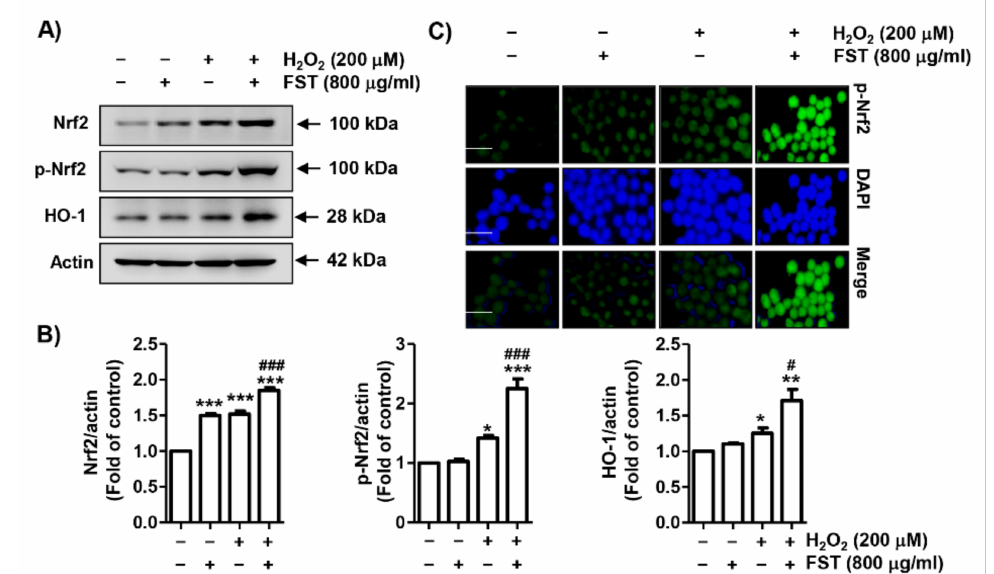
Figure 5. Activation of nuclear factor erythroid 2-related factor 2/ heme oxygenase-1 (Nrf2/HO-1) signaling pathway by FST in H 2 O 2 -treated MC3T3-E1 cells. Cells were pre-treated with or without FST (800 µ g/mL) and exposed to H 2 O 2 (200 µ M) for 24 h. ( A ) The expression of Nrf2, phos- phorylated (p)-Nrf2, and HO-1. Actin was used to loading control. ( B ) Relative band density expressed as fold of control cells. * p < 0.05, ** p < 0.01 and *** p < 0.001 vs. control cells. # p < 0.05 and ### p < 0.001 vs. H 2 O 2 -treated cells. ( C ) Immunofluorescence staining ofp-Nrf2 (green), 4 (cid:48) ,6 (cid:48) - diamidino-2-phenylindole (DAPI, blue) staining for nuclear staining. Representative micrographs are shown. Scale bar; 100 µ